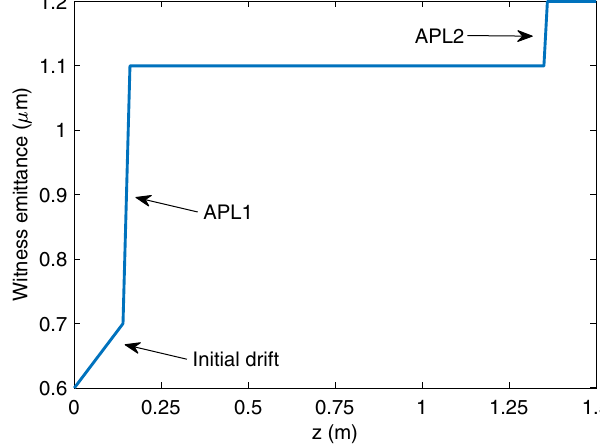
FIG. 5. Evolution of the witness envelope (blue line) and driver charge (red line) along the beam line. The insets show the x - z plane of the bunches at the entrance of the first APL, the collimator, and the second APL.